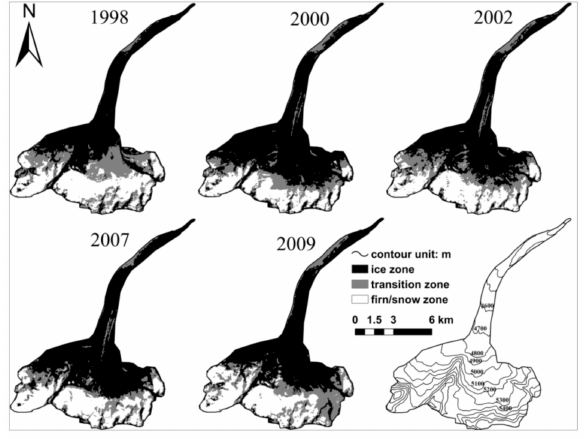
Figure 3. The distribution of bare ice and snow-covered areas based on appreciably different albedo on the Shamshar gang glacier in Western Himalayan in 1998, 2000, 2002, 2007, and 2009 [20].